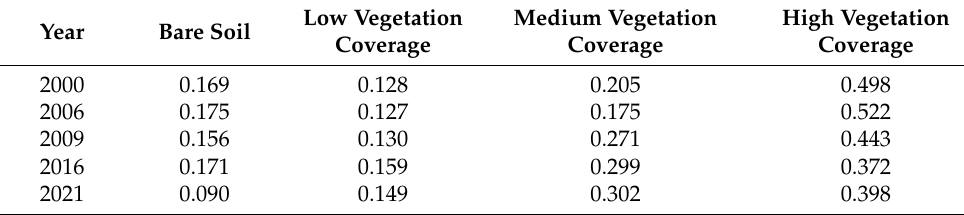
Figure 2. Changes in the coverage of the Muli region between 2000 and 2021. Table 2. Percentage area statistics of vegetation cover at all levels from 2000 to